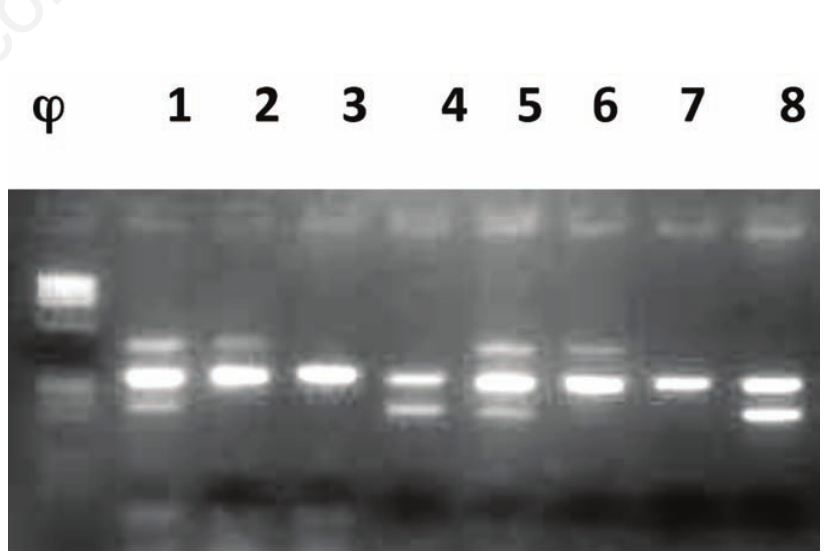
Figure 1. Polymerase chain reaction products of co-amplyfication of glutathione S trans- ferase (GST)M1 (215 bp), GSTT1 (480 bp) and amplification control CYP A1 (312 bp) tested on 3% agarose gel. Lane 1 and 5 genotype GSTM1+/GSTT1+. Lane 2 and 6 GSTM1-/GSTT1+ (GSTM1 Null). Lane 3 and 7 GSTM1-/GSTT1-. Lane 4 and 8 geno- type GSTM1+/GSTT1- (GSTT1